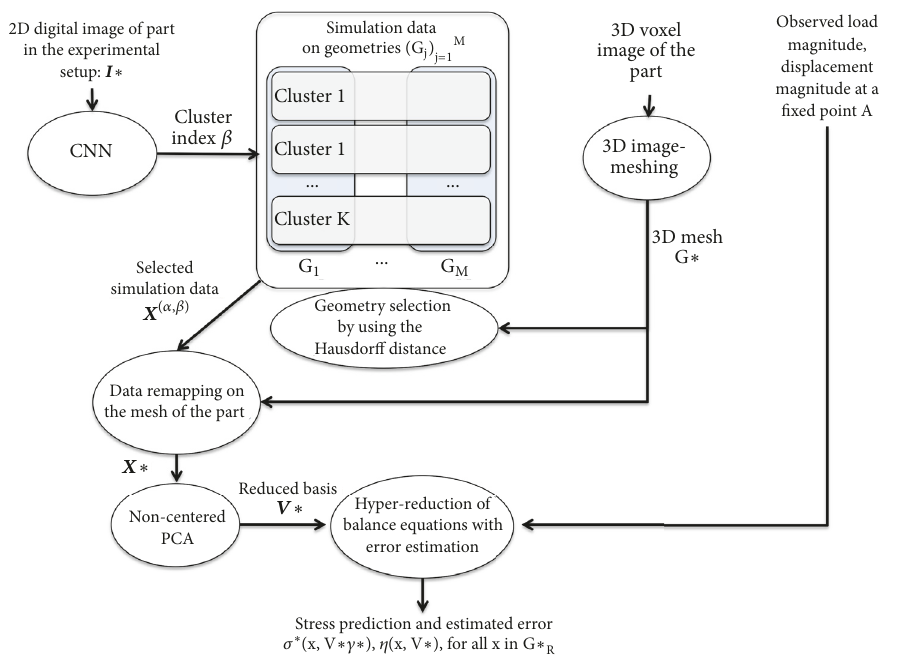
Figure 1: Workflow of the reduced order modeling via computer vision. The inputs are on the top of the figure; the outputs are the stress prediction 𝜎(𝑥, 𝑉 ∗ 𝛾 ∗ ) by using an hyperreduced order model and an error estimator 𝜂 related to the accuracy of the reduced basis 𝑉 ∗ .